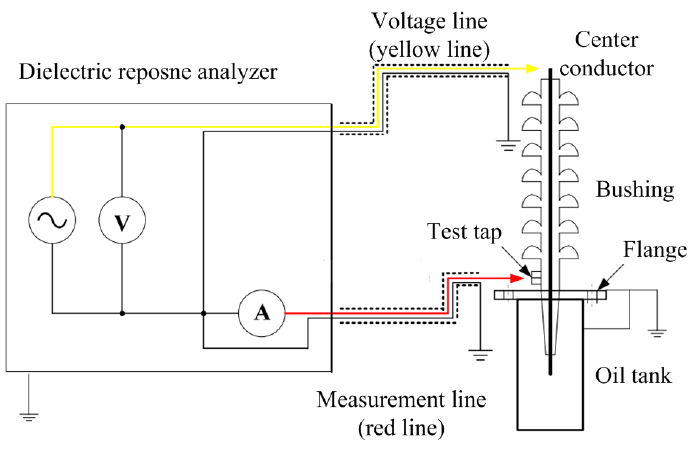
Figure 5. Scheme of frequency domain spectroscopy (FDS) instrumentation on the bushing.